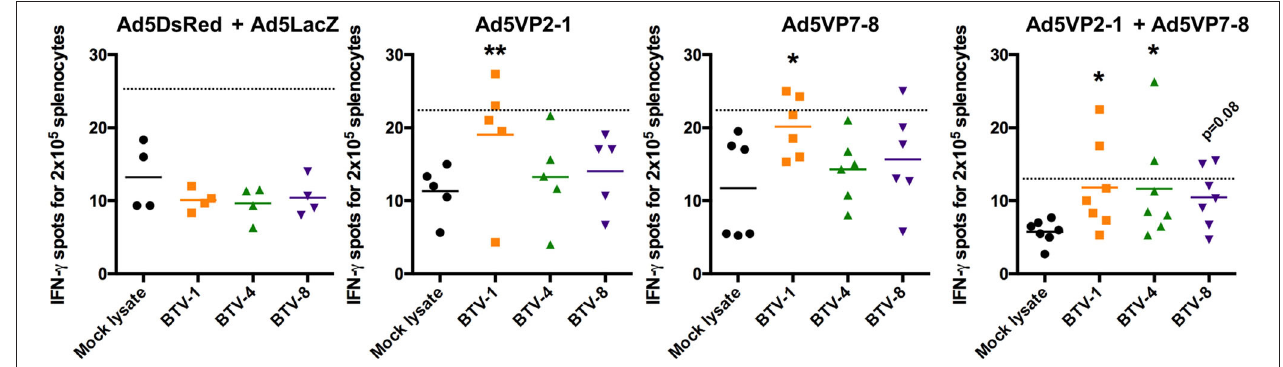
FIGURE 5 | The Ad5VP2-1 and Ad5VP7-8 immunization induces T-cell responses against homologous and heterologous BTV serotypes. IFN- γ ELISPOT assays of splenocytes from Ad5VP2-1, Ad5VP7-8, Ad5VP2-1 + Ad5VP7-8, or Ad5DsRed + Ad5LacZ immunized IFNAR ( − / − ) mice cultured with inactivated BTV-1, − 4, or − 8, or mock lysate as control. Mean IFN- γ spots for 2 × 10 5 splenocytes obtained from immunized mice are presented. * p < 0.05; ** p < 0.01; one-way ANOVA with Dunnett’s post-test (BTV-1, BTV-4, or BTV-8 vs. mock lysate). Dotted line indicates twice the mean of IFN- γ spots in mock lysate stimulated